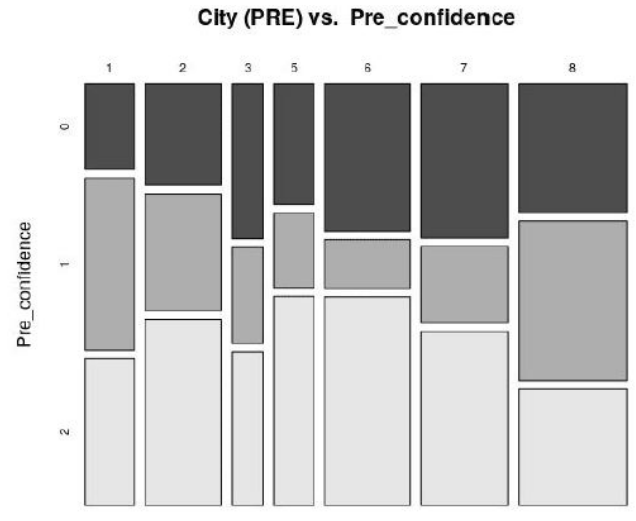
Figure 6. PRE-pilot: Comparison of the distribution of responses to confidence in technology among different pilots: neutral (0), No-Confidence (1) and Confidence (2).